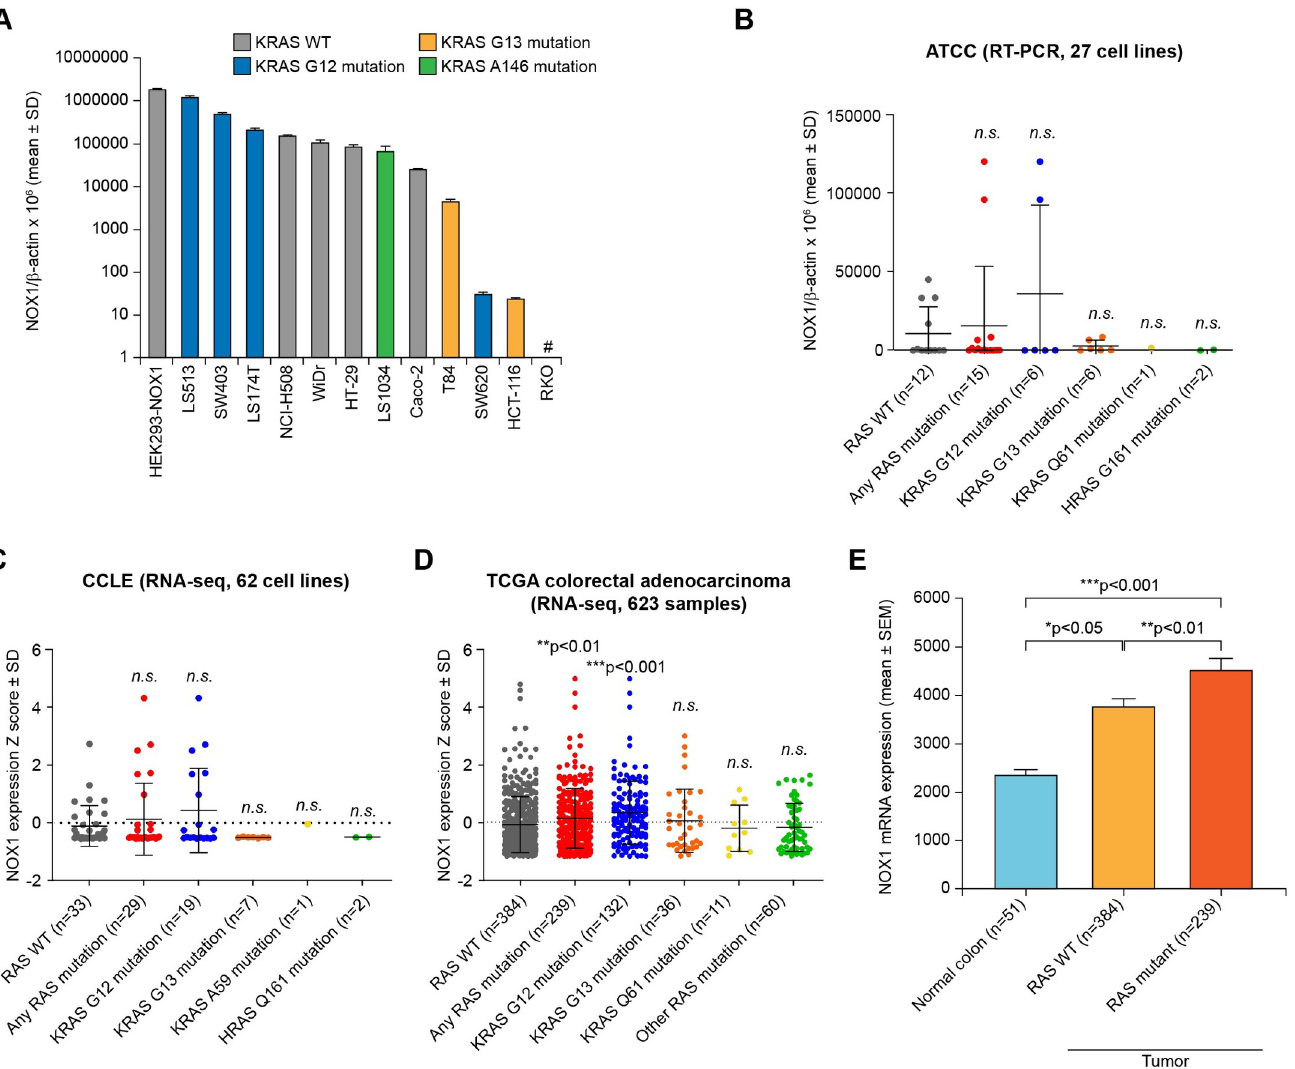
Fig 4. Expression of NOX1 and RAS mutation status in colon cancer cell lines and human colorectal tumor specimens. (A) NOX1 expression determined for a panel of 12 colon cancer cell lines plus HEK293-NOX1 at the mRNA level by qRT-PCR. NOX1 mRNA level is given relative to β -actin. Data represent mean ± SD for at least 3 independent experiments. Bars are color-coded according to KRAS mutation status. #, the RKO cell line is KRAS WT. (B) NOX1 expression was evaluated in a panel of 27 human colorectal cell lines at the mRNA level by quantitative real time PCR and is displayed relative to β -actin. Data represent mean ± SD for at least 3 independent experiments. (C, D) Relative NOX1 mRNA expression Z score in (C) 62 cell lines of the Cancer Cell Line Encyclopedia (CCLE) and (D) 623 colorectal adenocarcinoma specimens from The Cancer Genome Atlas (TCGA) stratified according to RAS mutation status. Each dot represents a cell line or tumor sample and the coloring corresponds to the RAS mutation status. (E) Mean NOX1 mRNA expression in 51 normal colorectal tissues from TCGA colorectal cohort was compared to expression in the 623 colorectal adenocarcinoma tumor samples from the same cohort shown in (D) , divided into RAS WT (n = 384) and RAS mutant (n = 239) groups. Data are ± SEM. Statistical significance for RAS WT vs. RAS mutant subcategories by the Mann-Whitney test: � p < 0.05, �� p < 0.01, ��� p < 0.001; n . s . denotes the absence of statistical